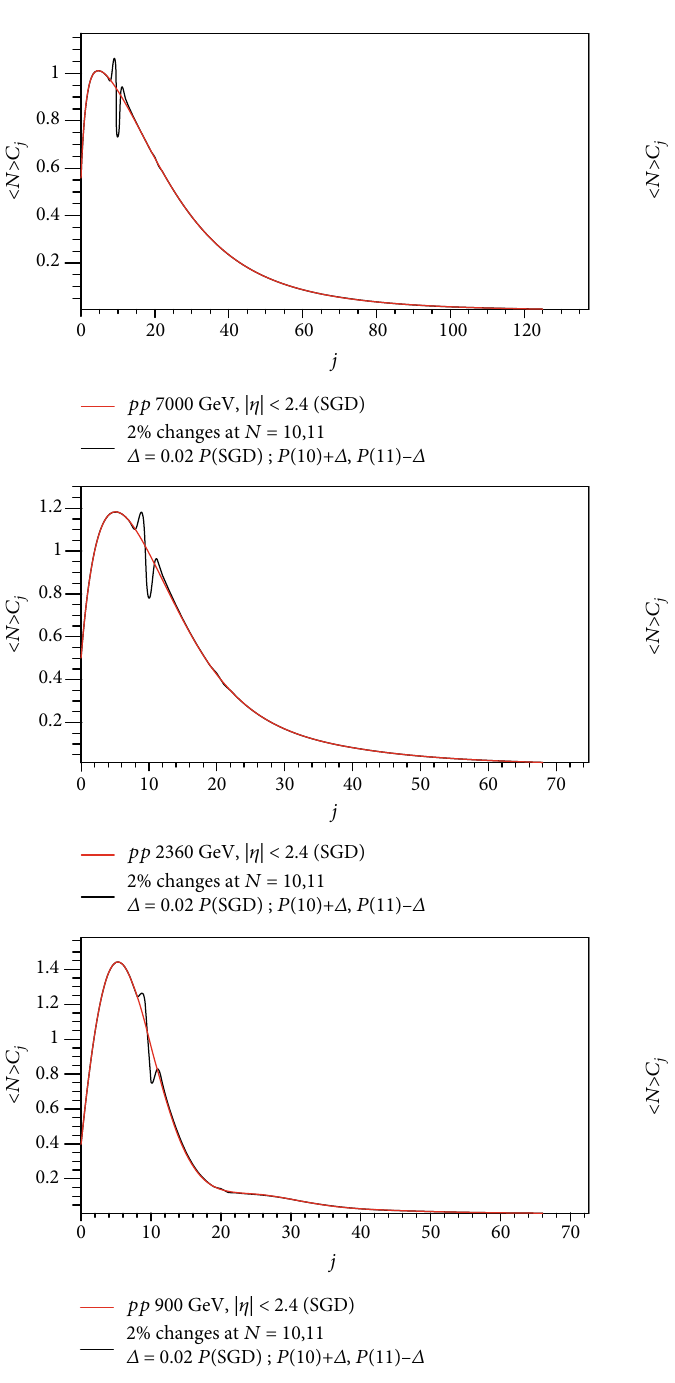
Figure 12: Illustration of oscillatory behaviour of the coe ffi cients C as described in the